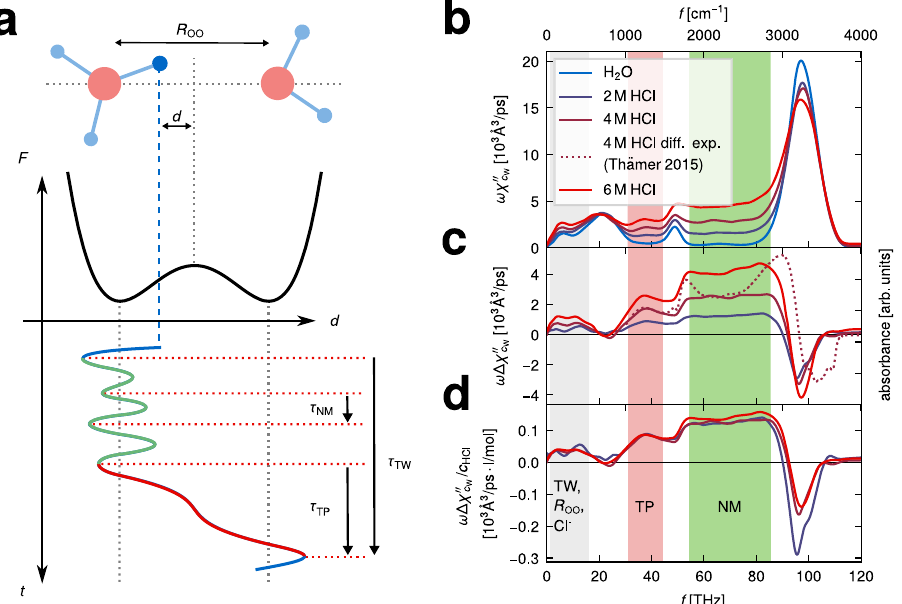
Fig. 1 Time scales of excess-proton dynamics and simulated absorption spectra. a Schematic trajectory of an excess proton that transfers between two water molecules, together with a schematic free energy pro fi le F ( d ) that exhibits a barrier and is representative of a relatively large oxygen-oxygen separation R OO . Three time scales characterize the proton trajectory, the normal-mode vibrational period of the solvated transient H 3 O + , τ NM , the transfer- path time, τ TP and the transfer-waiting time, τ TW , where τ TW > τ TP > τ NM . An animation is shown online https://fu-berlin.eu.vbrickrev.com/sharevideo/ df2d94a4-6e7f-499a-a256-17d73b6124e4. b Infrared (IR) absorption spectra obtained from ab initio molecular dynamics (MD) simulations of pure water (blue solid line) and hydrochloric acid (HCl) solutions at various concentrations (dark purple: 2 M, purple: 4 and red: 6 M). The spectra are divided by the water molecular number concentration c W . c Difference spectra between the three HCl spectra and the water spectrum, obtained from the spectra in b. The purple dotted line shows an experimental difference spectrum of HCl at 4 M 14 , rescaled in height to match the simulation results. d The simulated difference spectra (as shown in c ) divided by the HCl concentrations c HCl . Three distinct spectral regions are shaded in different colors, that are identi fi ed with different excess-proton dynamic processes: transfer waiting (TW, gray), transfer paths (TP, red), and normal modes (NM, green). The transfer-waiting time is close to the chloride-ion (Cl − ) rattling time and the oxygen vibrational time in local H 5 O 2 + complexes that is described by the R OO